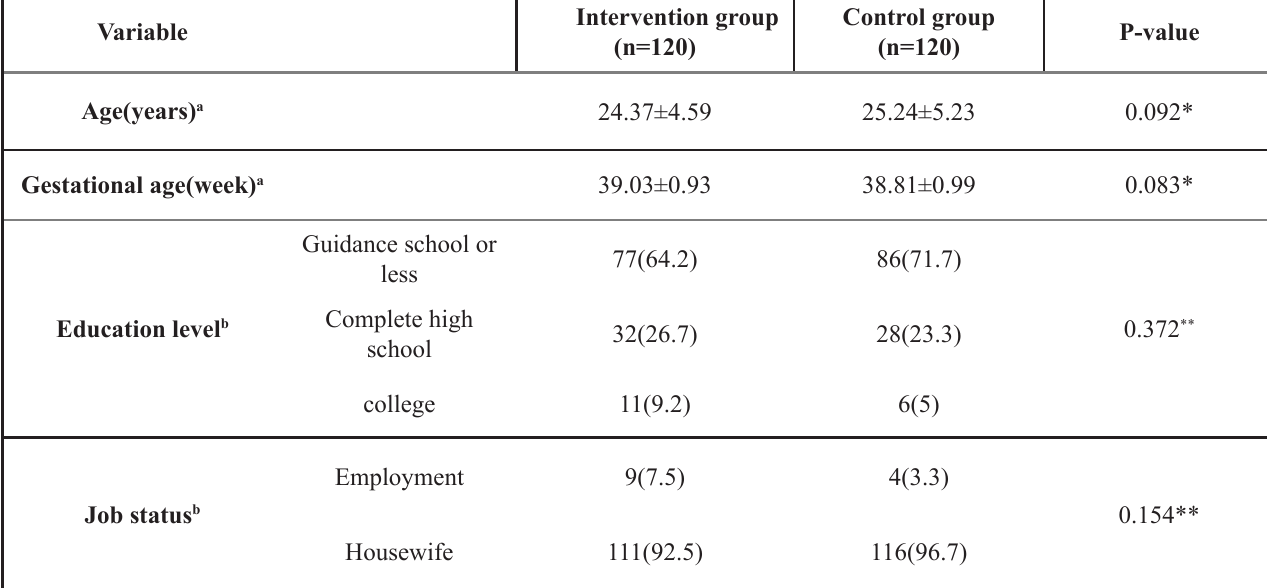
Table 1: Compare the characteristics of participants in intervention and control